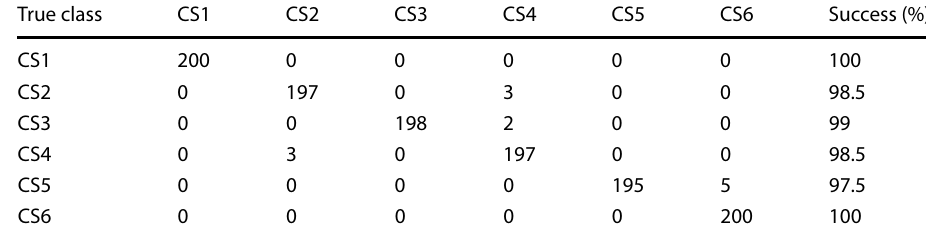
Table 12 Confusion matrix of testing data of PSO-based ELM